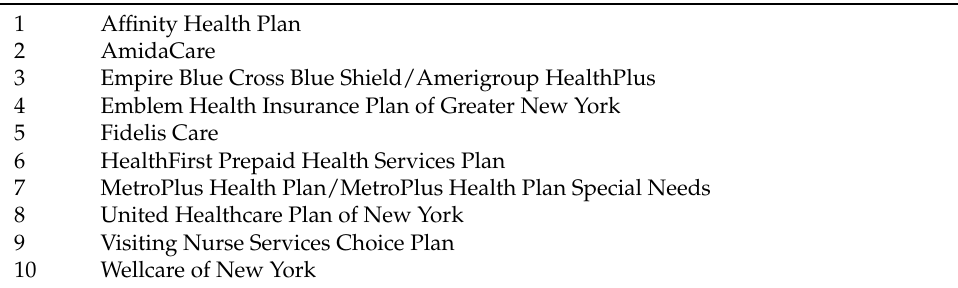
Table 1. Ten most common Medicaid MCO plans in